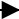
Fig. 1. Time/altitude colour plot of ( from top to bottom ) the electron concentration, the electron temperature, the ion temperature and the line-of-sight ion velocity, from UHF ( top panel ) and VHF ( bot - tom panel ) French special-program observations. The time resolu- tion (postintegration) is 5 min. The temporal evolution of electric field resulting from the tristatic UHF radar analysis is added on the UHF panel: the northward component ( red ) and the eastward com- ponent ( green ) are plotted in units of mVm